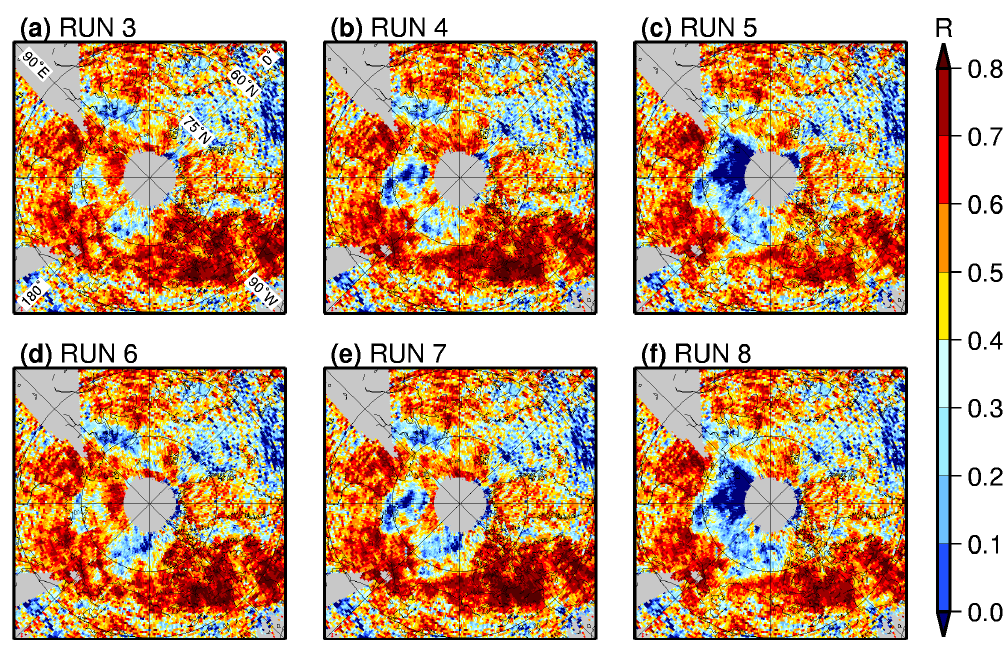
Fig. 14. The same as Fig. 13 but for GEM-AQ BrO AVCDs recalculated by adding extra BrO to the original model output, viz. 0.5pmolmol − 1 from the surface up to GEM’s dynamical tropopause and 3pmolmol − 1 from the dynamical tropopause up to the 200hPa